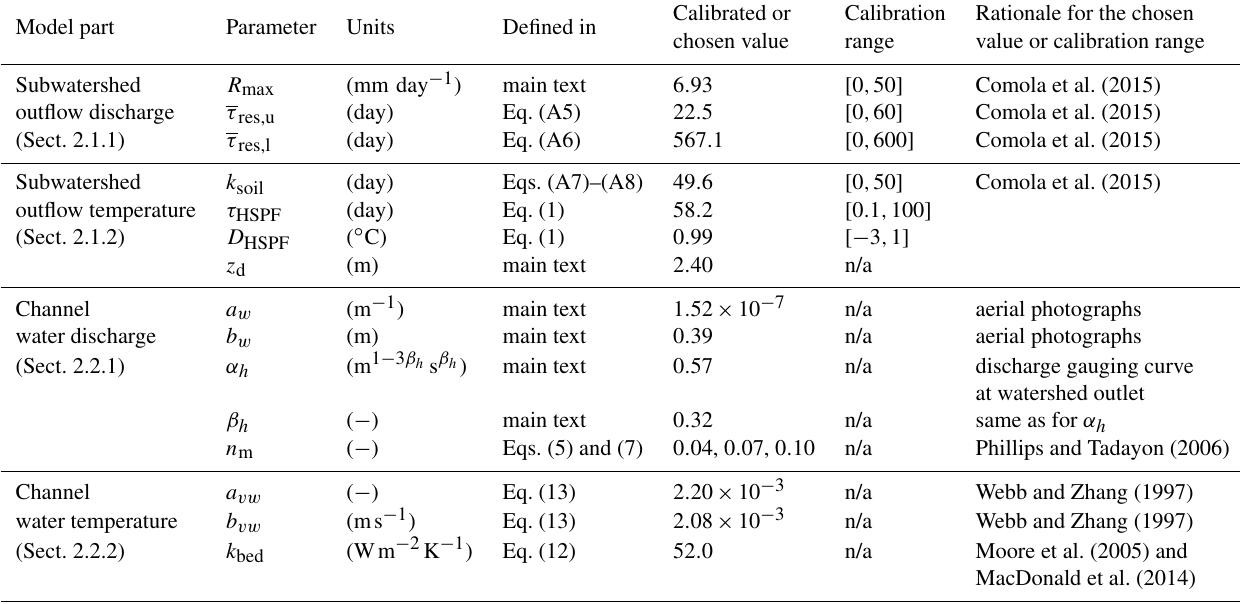
Table 2. Parameters used by StreamFlow to simulate water depth, discharge and temperature using various approaches. The parameters are described in more detail in the main text (Sect. 2 and Appendix A). First column of the table mentions the part of the model in which the parameter is used. The absence of a calibration range (marked as n/a) indicates a fixed parameter.